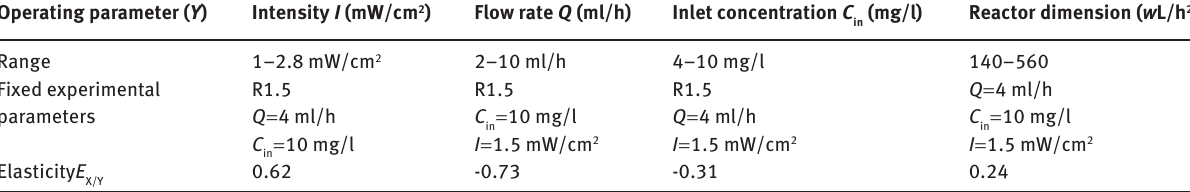
Table 3 Values of the elasticity of the degradation with respect to key operating